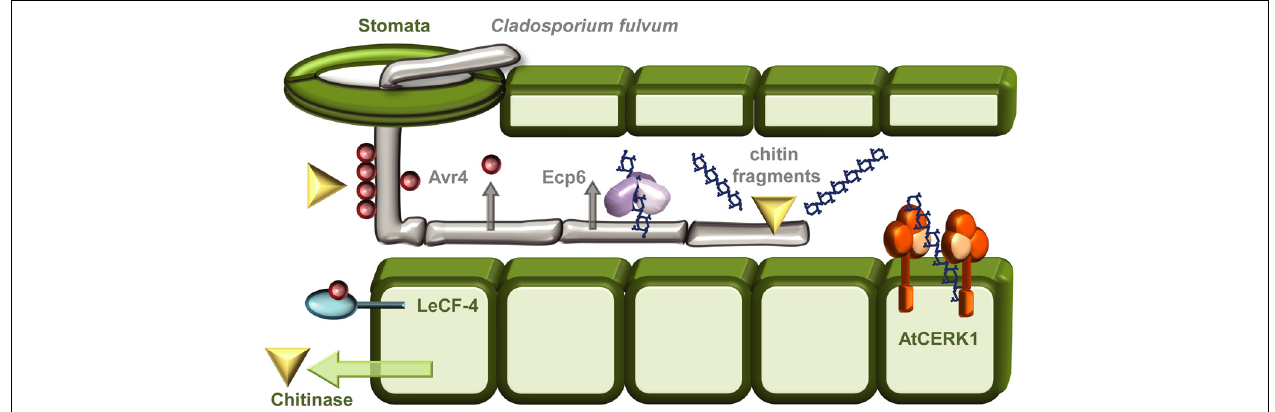
FIGURE 1 |The “arms race” between Cladosporium fulvum and plant hosts. As a general protective measure against fungal infections plants respond to infection attempts by secreting chitinases into the apoplastic space.The tomato leaf mould fungus C. fulvum can enter its host through stomatal openings, and grows as extracellular hyphae.To shield against the action of these chitin-degrading enzymes the fungus camouflages its chitin-containing cell walls by cloaking them with the chitin-binding effector Avr4 (van den Burg etal., 2006; Hadwiger, 2013).The presence of Avr4 can be